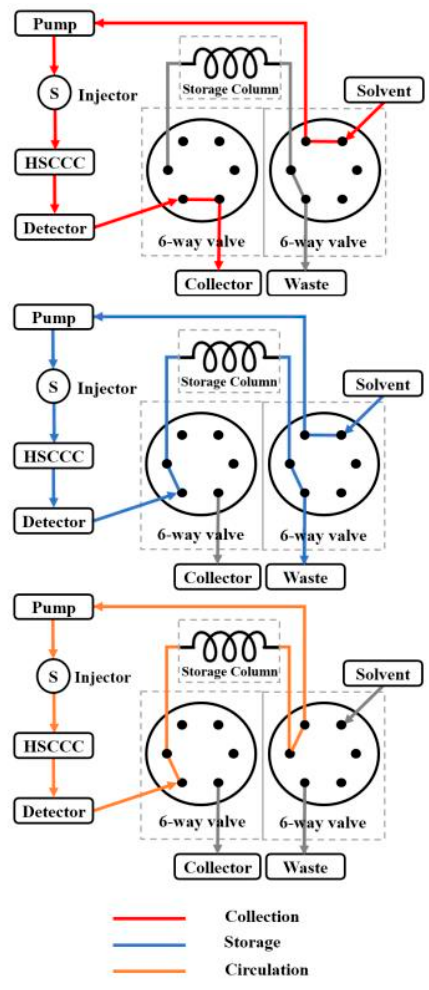
Figure 3. The switch sketch of three different patterns.